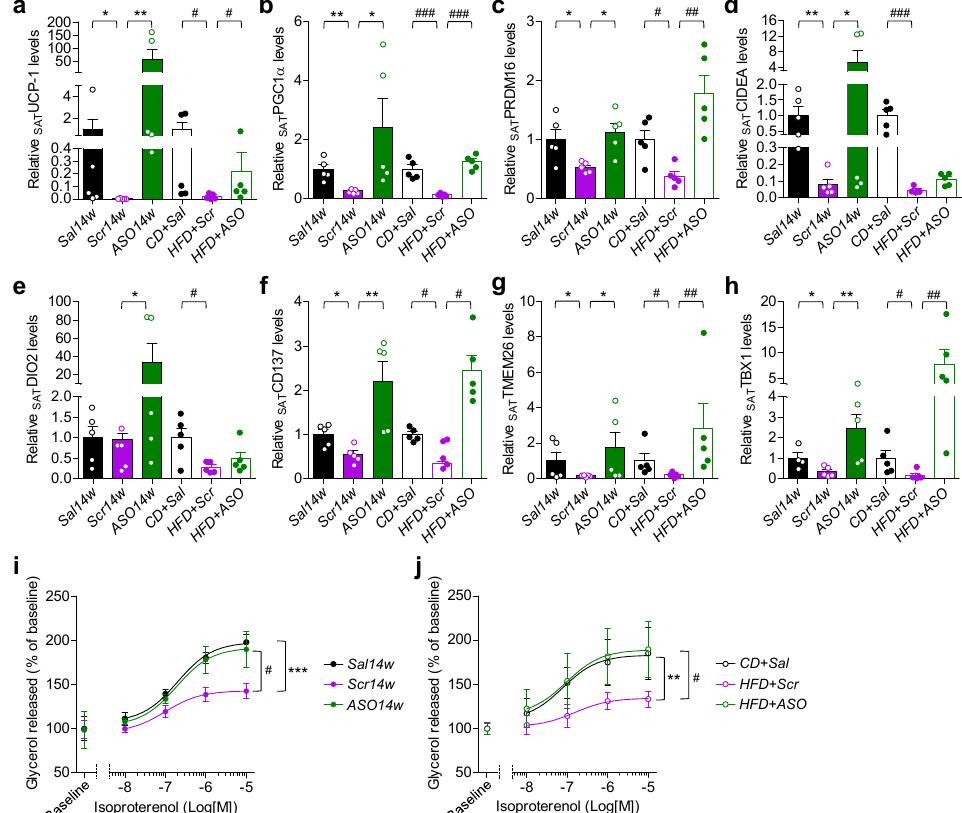
VAT ( e , f ) and ( g , h ). Scale bar located in the top left corner of every image is 100 µ m. ( i − n ) mRNA levels of inflammatory cytokines in SAT and VAT measured by qRT-PCR. SAT ( i ) IL - 1 β , ( j ) IL - 6 and ( k ) TNF - α and VAT ( l ) IL - 1 β , ( m ) IL - 6 and ( n ) TNF - α . Filled bars show results from the prevention and empty bars from the reversibility studies. For the quantitative analyses, data are expressed as mean ± SD of n = 3 individual mice per experimental group and controls; for the qRT-PCR experiments, data are expressed as mean ± SEM of n = 4–5 individual mice per experimental group and controls. * p < 0.05; ** p < 0.01; *** p < 0.001 for differences in the prevention study. # p < 0.05; ## p < 0.01; ### p < 0.001 for differences in the reversibility study.